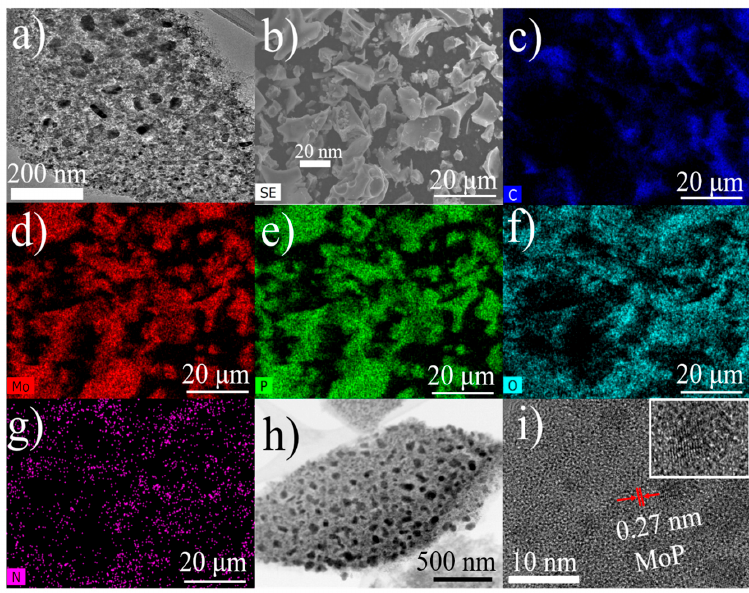
Figure 1. MoP/NPC: ( a ) TEM; ( b ) SEM image; ( c − g ) EDS elemental mappings of C, Mo, P, O, and N; ( h ) Scanning transmission electron microscopy (STEM) image; ( i ) HRTEM image (inset: detailed).